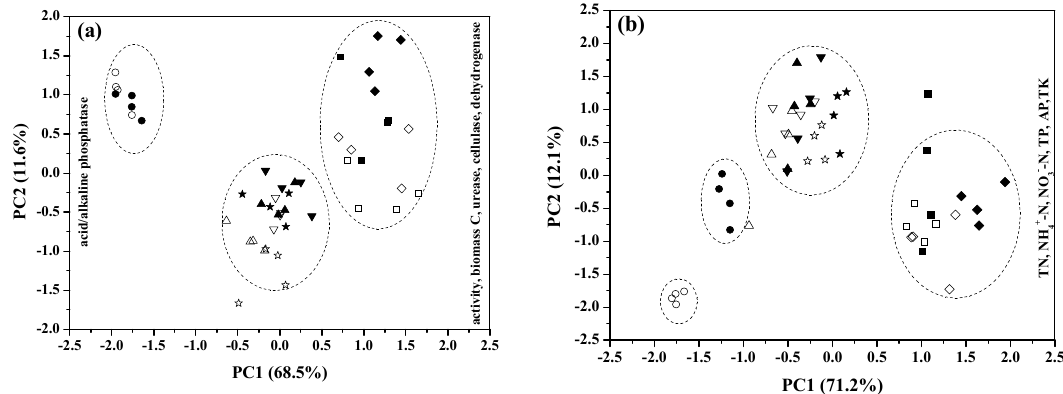
Figure 3. Bioplot of the principal components on soil nutrient and microbial properties (n = 48). ( a ) Microbial properties, ( b ) Nutrient profiles. PC1: the first principal component; PC2: the second principal component. The most important parameters for the definition of the two components are shown on the edge of each axis, indicating the direction in which the value of the parameter increases. Symbols: control1 ( ○ ), control 2 ( ● ), lime1 ( △ ), lime1 + NPK ( ▽ ), lime1 + P ( ☆ ), lime1 + Rs ( □ ), lime1 + NPK + Rs ( ◇ ), lime2 ( ▲ ), lime2 + NPK ( ▼ ), lime2 + P ( ★ ), lime2 + Rs ( ■ ), lime2 + NPK + Rs ( ◆ ).